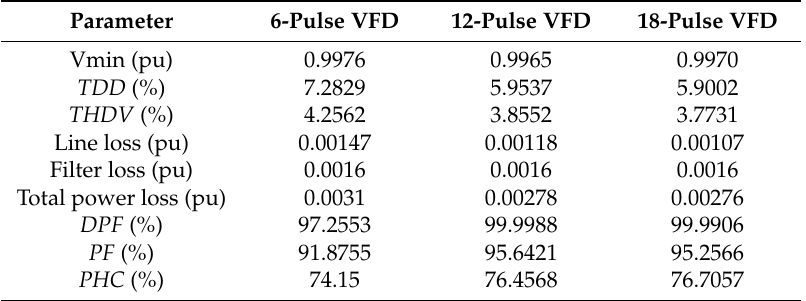
Table 6. Operational parameters and PHC results obtained using multi-pulse VFD